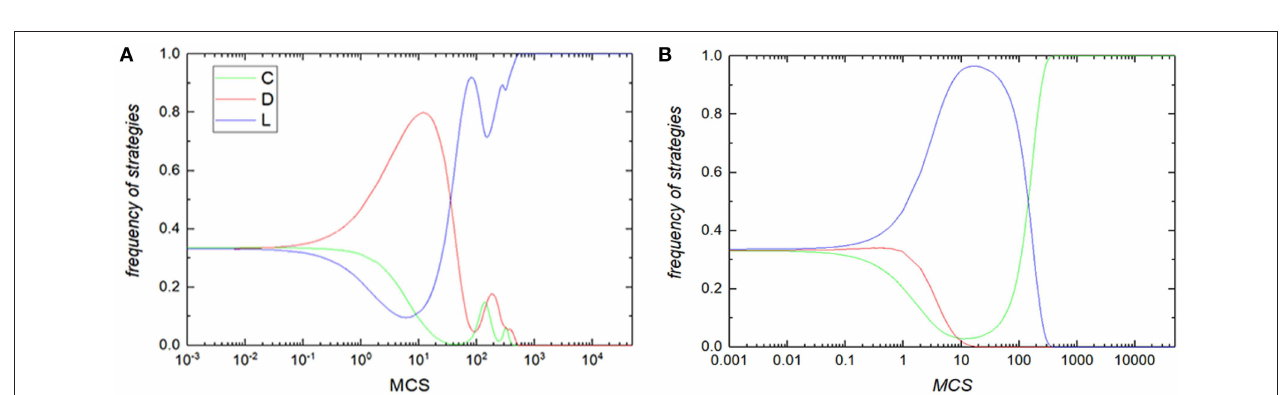
FIGURE 6 | Average frequency of cooperators (top row),defectors (middle row) and loners (bottom row) evolves with the temptation b and loners’ payoff σ for different reciprocal rewarding strength β at the stationary state in the voluntary PDG. From left to right, the strength of the reciprocal rewarding is 0.0, 0.1, 0.2, 0.3, 0.4, and 0.5, respectively. In all simulations, other parameters are set to be L = 100, MCS = 5 × 10 4 , K = 0.1.